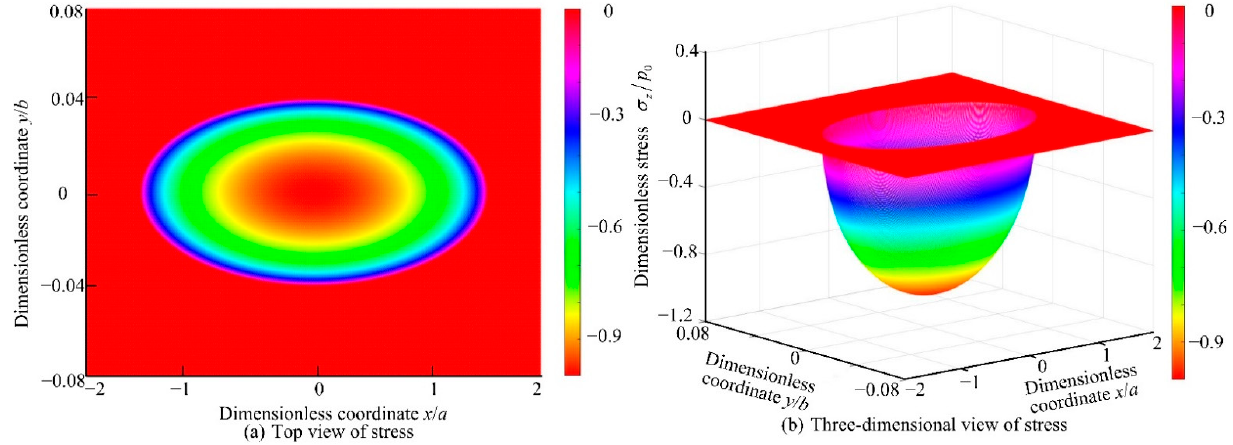
Figure 6. Distribution of dimensionless stress σ z / p 0 for k = 0.8 and µ = 0.15.